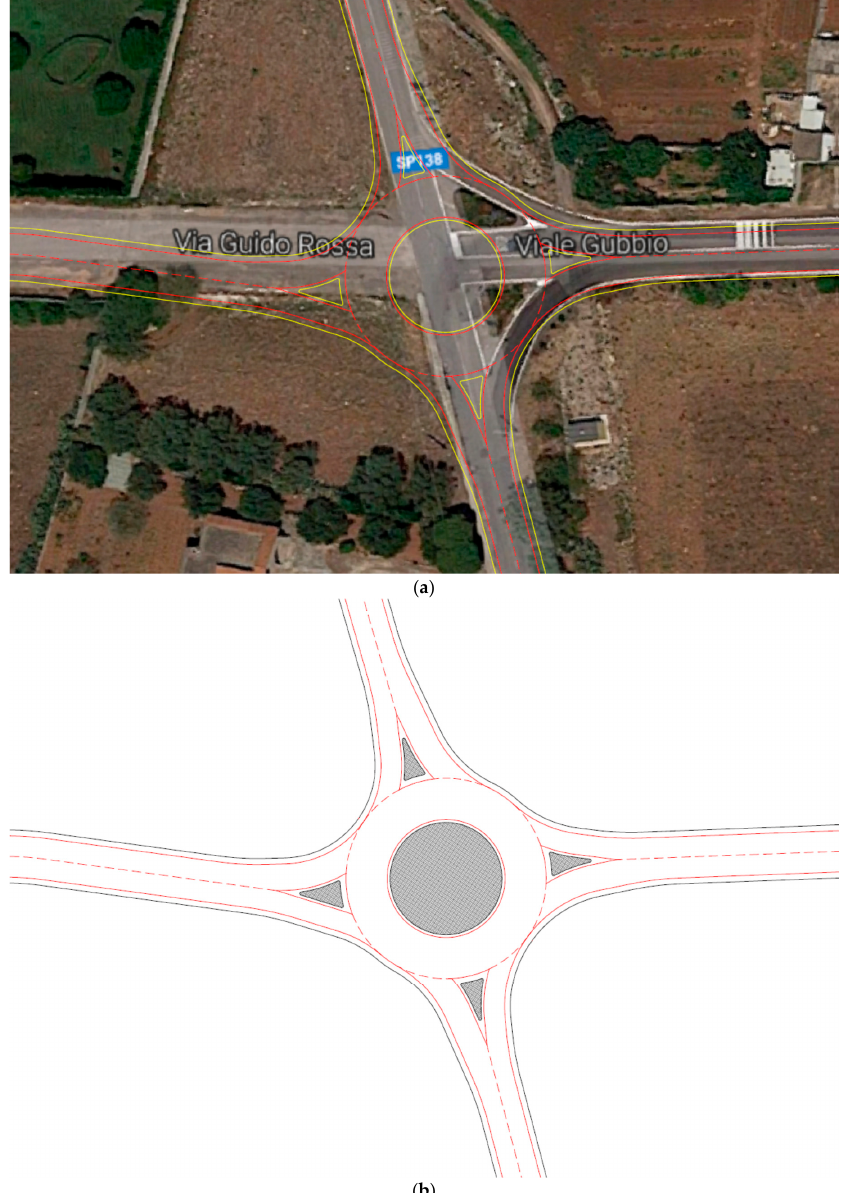
Figure 5. ( a ) Superimposition of the design on raster map (photo: Google maps) ( b ) Geometric design of the roundabout.